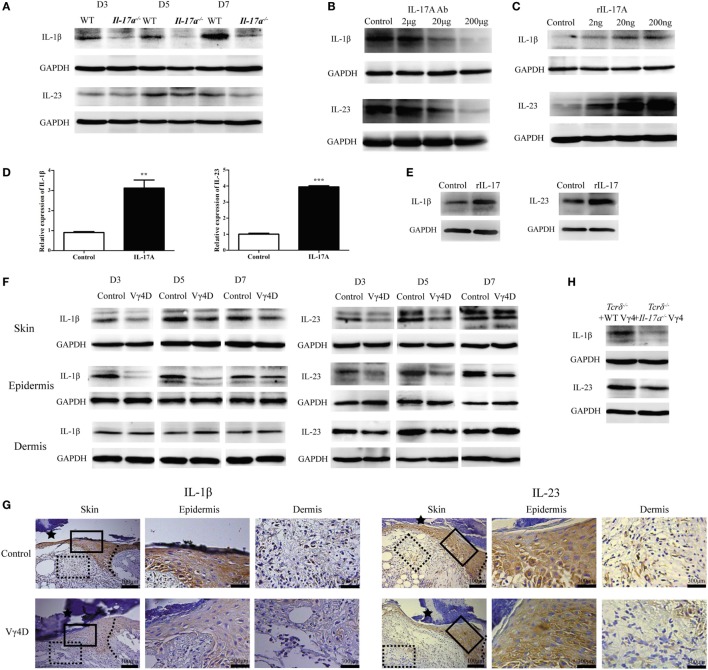
Vγ4 T cell-derived IL-17A enhanced the production of IL-1β and IL-23 in epidermis around wound. (A) The expression of epidermal IL-1β and IL-23 around wound of wild-type (WT) and Il-17a−/− mice was analyzed by WB on days 3, 5, and 7 post-excision (n = 3/group). (B) Age- and sex-matched WT mice received various doses of IL-17A neutralizing Ab treatment (doses of 0, 2, 20, and 200 μg/wound) in the wound margin on days 0, 1, and 2 post excision. WB analysis of IL-1β and IL-23 expression in epidermal wound margin on day 3 post excision (n = 3/group). (C) WT mice were injected with various doses of rIL-17A treatment (doses of 0, 2, 20, and 200 ng/wound) in the wound margin for continuous 3 days following excision. IL-1β and IL-23 expression in epidermal wound margin was analyzed by WB on day 3 post excision (n = 3/group). (D,E) Fresh isolated primary keratinocytes cultured with IL-17A (100 ng/ml) for 24 h. The expression of IL-1β and IL-23 was measured by qPT-PCR (D) and WB (E). (F,G) The expression of IL-1β and IL-23 in whole skin, epidermis, and dermis around wound of Vγ4D and WT control mice was assessed by WB on days 3, 5, and 7 post-excision (F) and IHC (G) on day 3 post-excision. (H) WT or Il-17a−/− Vγ4 T cells were added onto wound bed of Tcrδ−/− mice upon wounding (n = 4/group). The production of IL-1β and IL-23 in epidermis at wound edge was analyzed by WB on day 3 post-excision. Data represent three independent experiments using the indicated number of mice in brackets for each group or mouse strain. P value was assessed by Student’s unpaired t-test (**P < 0.01, ***P < 0.001).